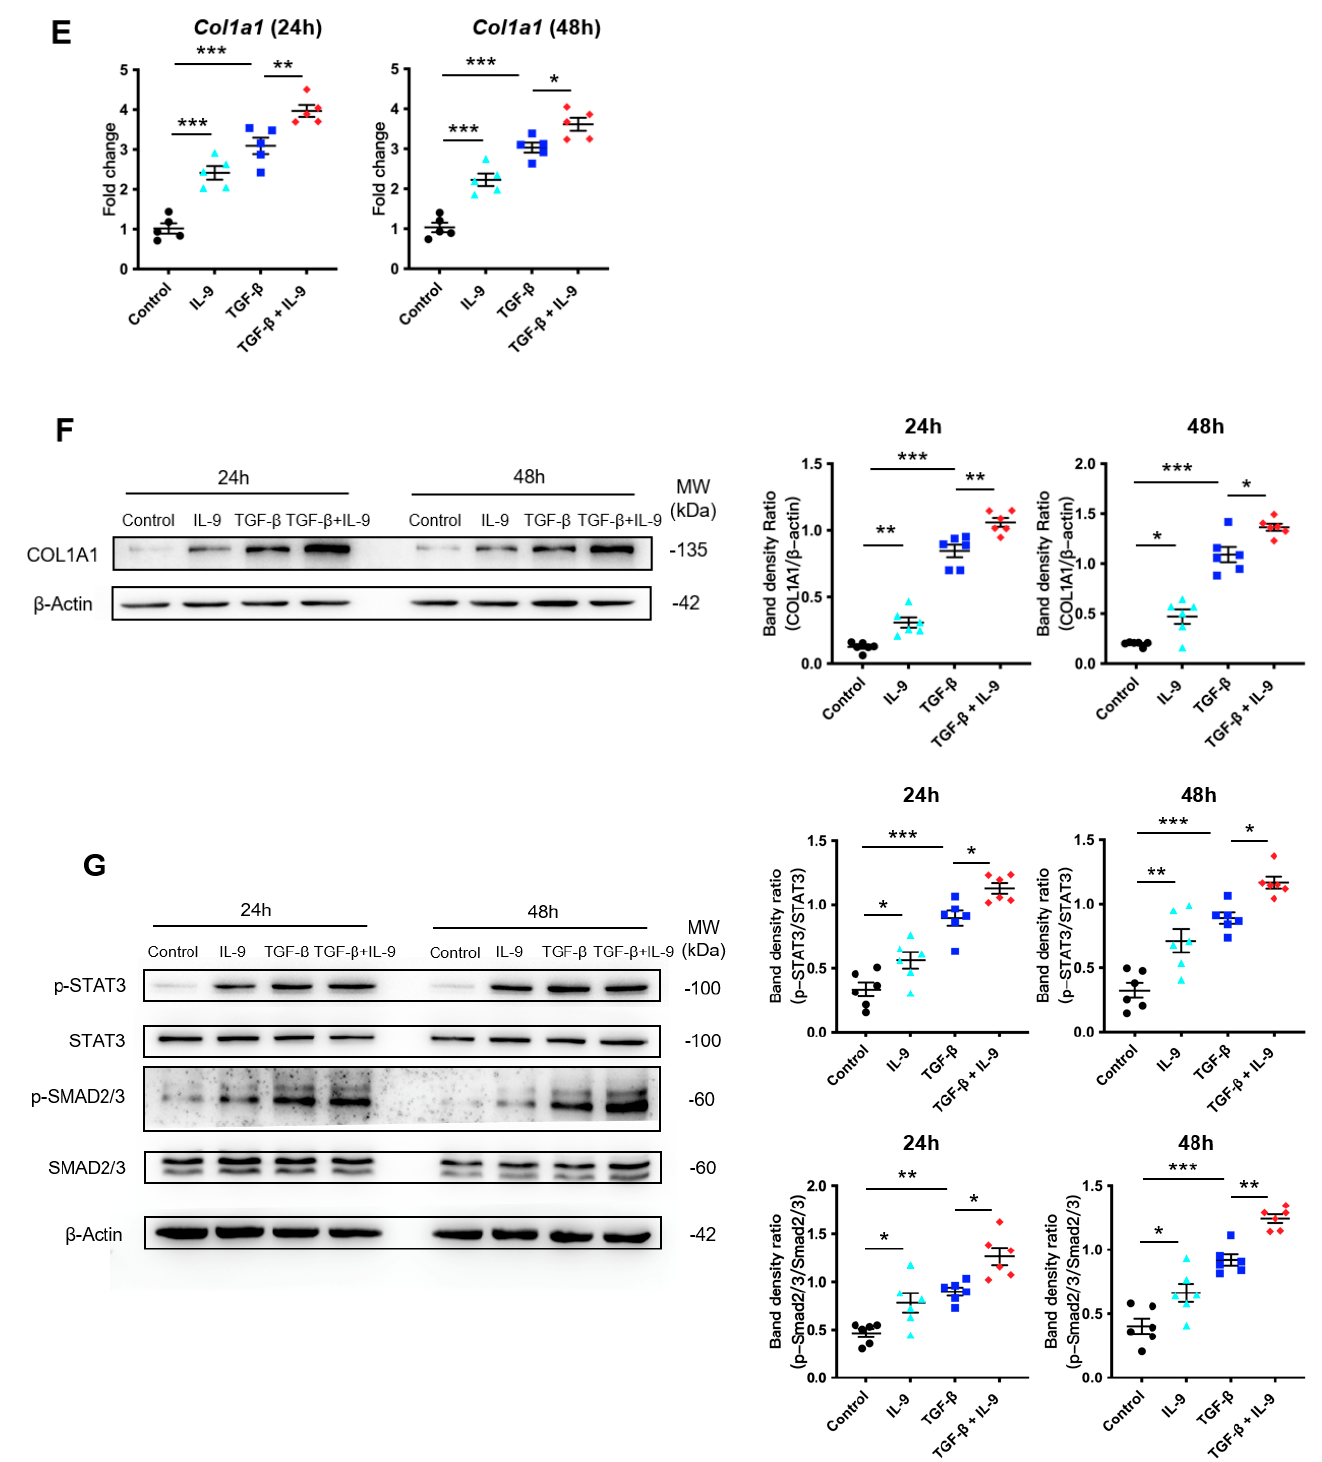
Figure 3. IL-9 promotes fibroblast proliferation and activation in vitro. ( A ) IL-9 (10 ng/mL, 24 h or 48 h) increased proliferation of primary mouse lung fibroblasts in the presence or absence of TGF- β (5 ng/mL) examined by CCK8 assay. ( B ) Quantitative PCR analysis of α -SMA in primary mouse lung fibroblasts treated with IL-9 (10 ng/mL, 24 h or 48 h) in the presence or absence of TGF- β (5 ng/mL). ( C ) Representative images and quantitative analysis of α -SMA immunostaining in primary mouse lung fibroblasts treated with IL-9 (10 ng/mL, 24 h or 48 h) in the presence or absence of TGF- β (5 ng/mL) (n = 4). Scale bars, 200 μ m. ( D ) Representative Western blot images and quantitative analysis of α -SMA in primary mouse lung fibroblasts treated with IL-9 (10 ng/mL, 24 h or 48 h) in the presence or absence of TGF- β (5 ng/mL) (n = 6). β -Actin was used as a loading control. ( E ) Quantitative PCR analysis of Col1a1 in primary mouse lung fibroblasts treated with IL-